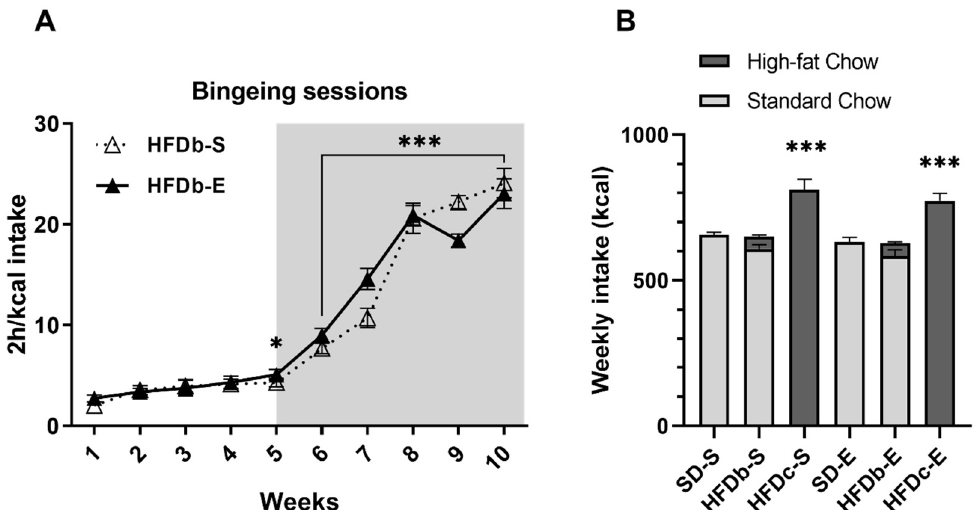
Figure 2. ( A ) Binge sessions. Caloric intake (kcal) of high-fat diet (HFD) in the 2-h high-fat binge-eating sessions that took place on Monday, Wednesday and Friday in the high-fat diet binge (HFDb) groups. The mean ( ± SEM) amount of kcal consumed in 2 h of access to high-fat food in every binge session * p < 0.05; *** p < 0.001 significant difference with respect to the first and second binge sessions. ( B ) Weekly energy consumption per cage (four mice) across the procedure. Mean ( ± SEM) 24 h energy consumption (kcal) of mice (standard chow shown by open bars and HFD by solid bars) *** p < 0.001 significant difference of both continuous high-fat diet (HFDc) groups with respect to the standard diet (SD) groups and HFDb